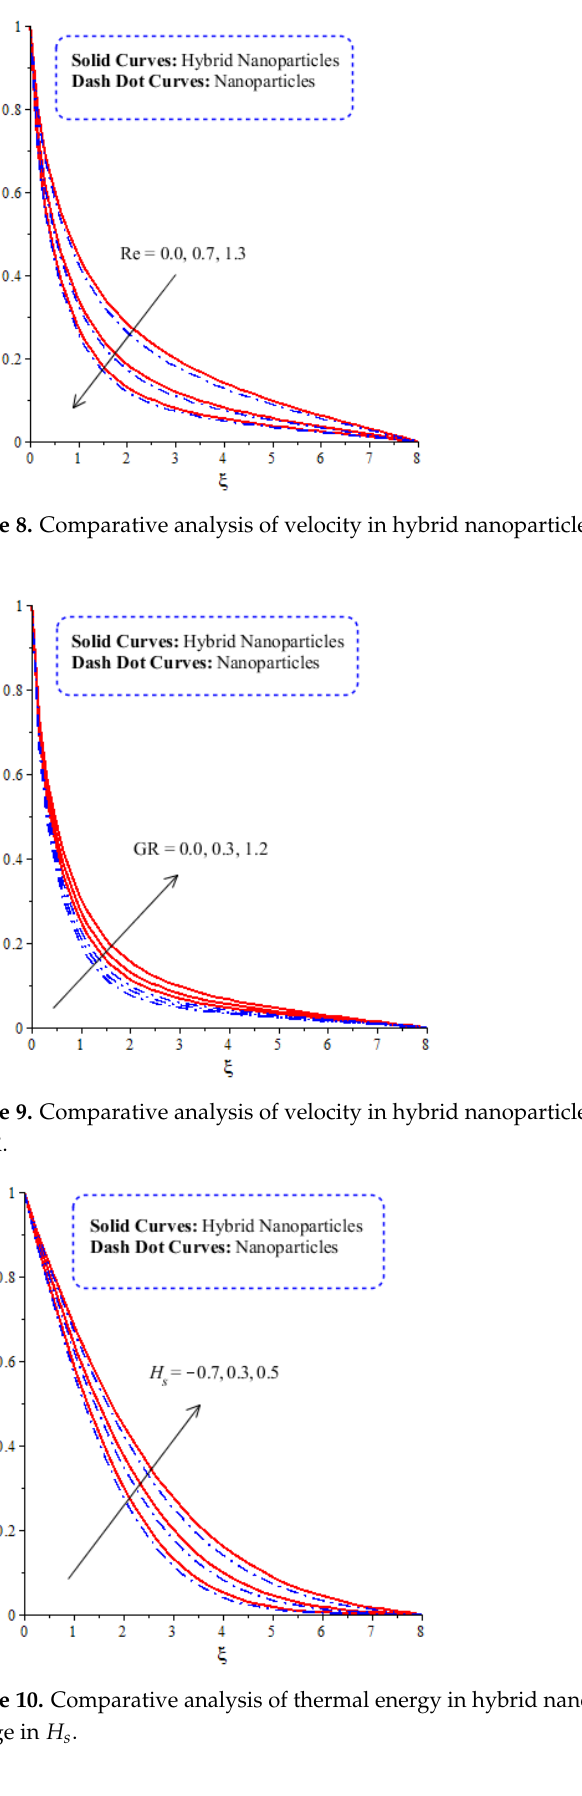
Figure 7. Comparative analysis of velocity in hybrid nanoparticles and nanoparticles versus change in 𝑚 .